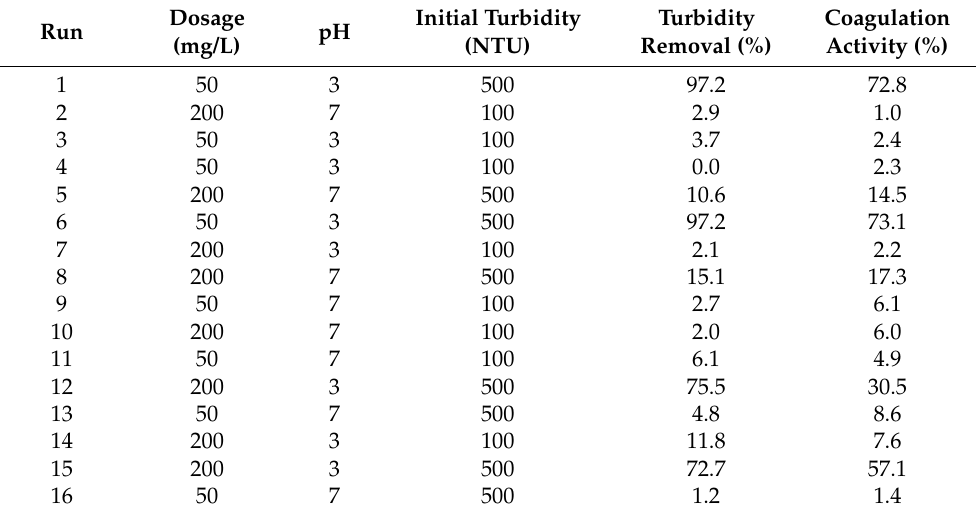
Table 4. Turbidity removal efficiency and coagulation activity from synthetic kaolin water using deshelled Carica papaya seeds.